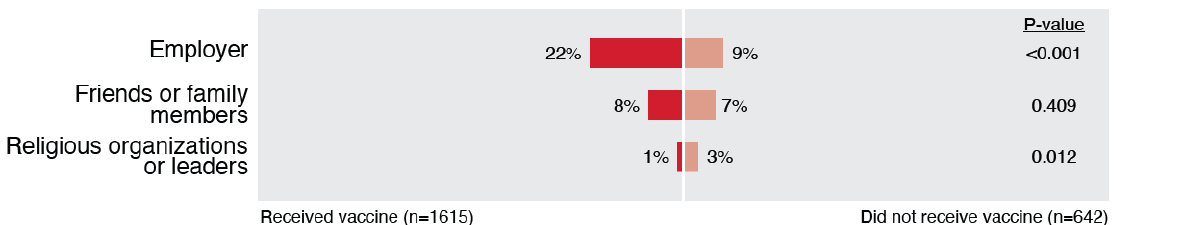
Figure 7. Differences in trust in employer and community between vaccinated and unvaccinated EMS professionals. “ Figure 8. Participant perspectives regarding mistrust in employer and community.